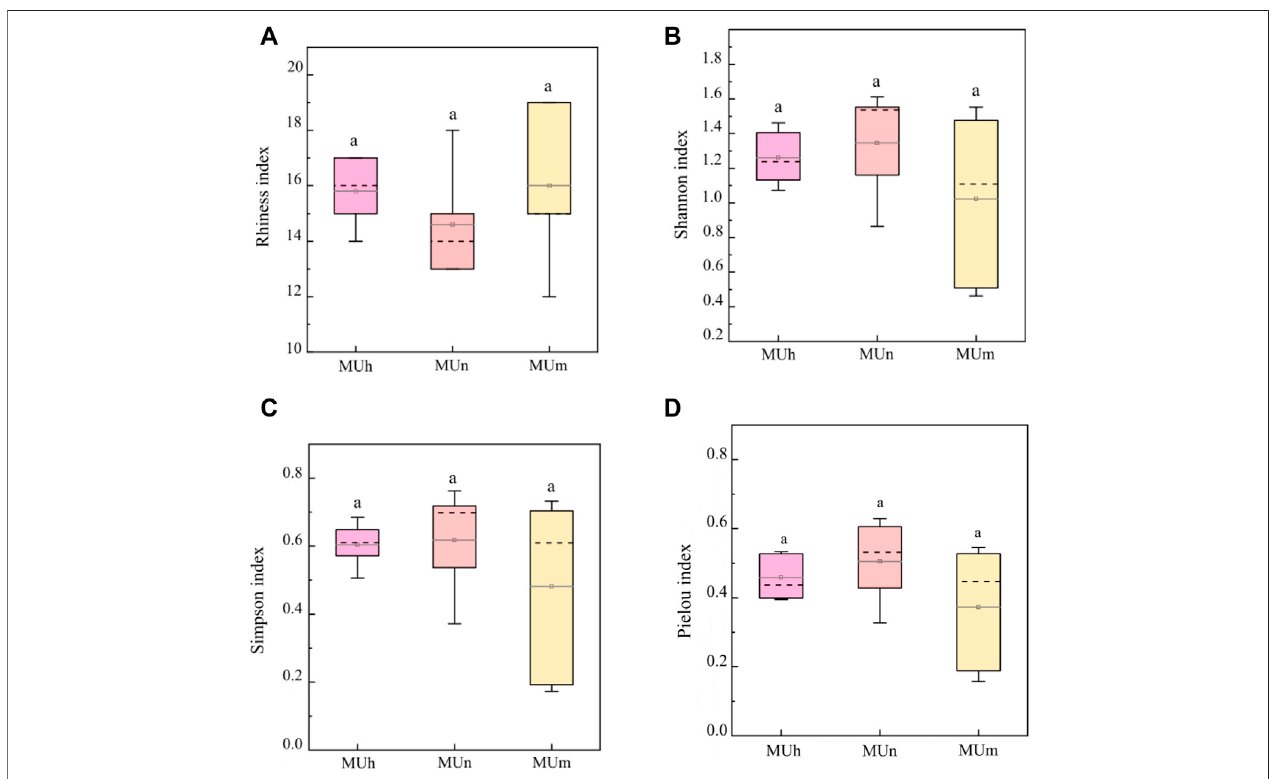
FIGURE1| DiversityoftheEcMfungiassociatedwith P.sylvestris atdifferentagegroups.Lettersindicatesigni fi cantdifferencesforeachparameter( p < 0.05;one- way ANOVA, Tukey test) based on the values determined for each site (5 replicates/site). (A) Rhiness index, (B) Shannon index, (C) Simpson index, (D) Pielou